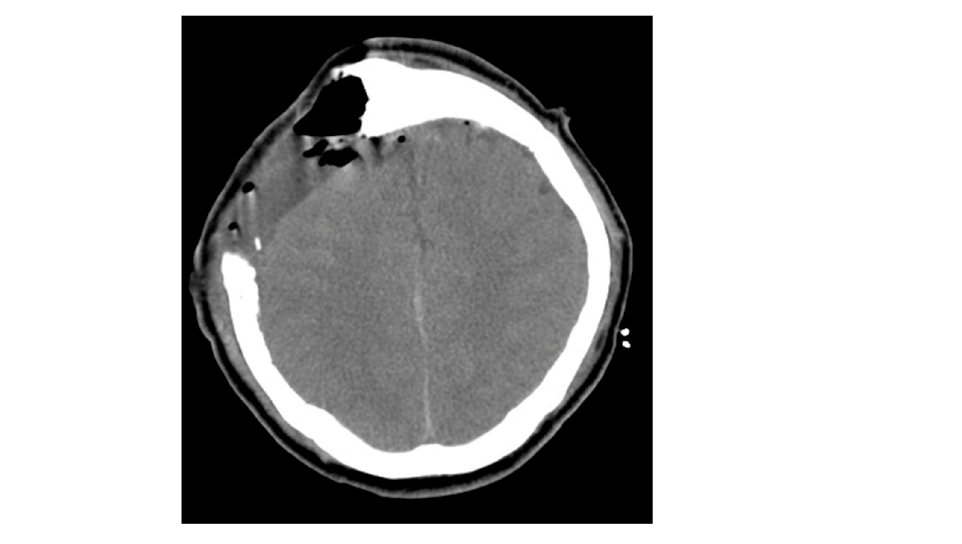
Figure 5. Follow-up brain MRI with diffusion tensor imaging(DTI). ( A ) brain MRI with diffusion- weighted image (DWI) revealed no tract injury or parenchyma damage. ( B ) brain MRI with apparent diffusion coefficient (ADC) revealed no acute infarction After EDH removal, general condition and consciousness level returned to a stable status, but the muscle power of limbs and mutism aphasia still showed no improvement in the intensive care unit. A rehabilitation program was recommended. Two weeks after the tumor removal and rehabilitation, mutism aphasia was resolved to normal level. Seven weeks after tumor removal and rehabilitation, muscle power of the left upper limb improved from grade 1 to 5, and muscle power of both lower limbs returned from grade 1 to 4. Final pathology report illustrated meningioma, WHO grade I, which involved not only the meninx, but also the scalp and skull. 2.2. Literature Review and Case Analysis We used SMA syndrome and falx/parasagittal meningioma as keywords for an English literature search in PubMed. Including our case, only 12 cases of the development of SMA syndrome after falx/parasagittal meningioma resection have been reported in the literature (Table 1). Inclusion criteria were SMA syndrome and parasagittal meningioma. Exclusion criteria were children and non-English literature.